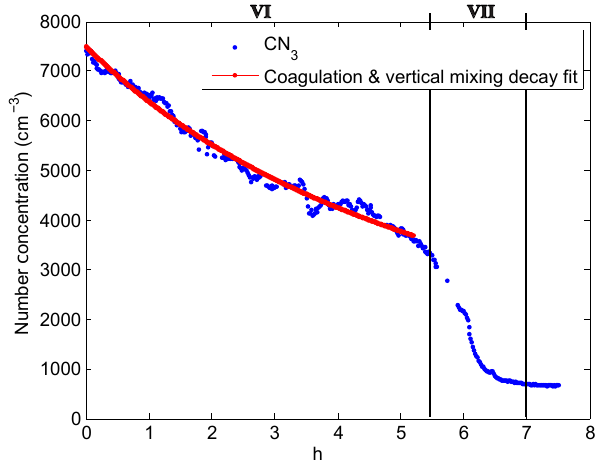
Figure 6. CN 3 data with the coagulation and vertical mixing decay fit that is found to fit for the first 5h of decay, before an air-mass change results in rapid decay to background at around 5.5h. Zero hours corresponds to midday on the 18 October